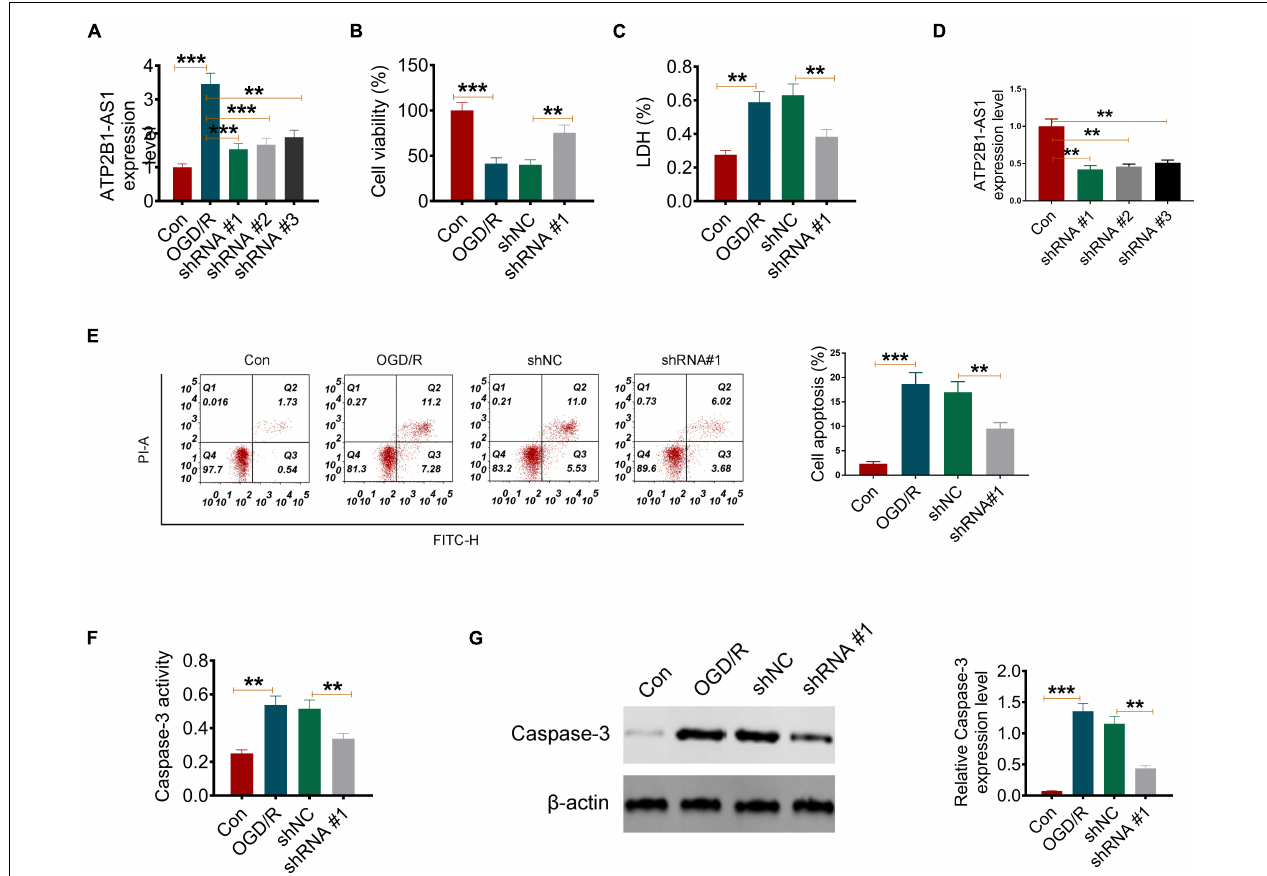
FIGURE 2 | Knockdown of ATP2B1-AS1 inhibits apoptosis and apoptosis-related factors of OGD/R PC12 cells. (A) The expression of ATP2B1-AS1 downregulated by shRNA ATP2B1-AS1 in the OGD/R-induced PC12 cells. (B) Knockdown of ATP2B1-AS1 increases the cell viability of OGD/R PC12 cells. (C) Knockdown of ATP2B1-AS1 reduces the LDH level of OGD/R PC12 cells. (D) The expression of ATP2B1-AS1 downregulated by shRNA ATP2B1-AS1 in PC12 cells without OGD/R treatment. (E) Knockdown of ATP2B1-AS1 inhibits the apoptosis rate of PC12 cells induced by OGD/R. (F) Knockdown of ATP2B1-AS1 decreases the Caspase 3 level of OGD/R PC12 cells. (G) Knockdown of ATP2B1-AS1 decreases the Caspase 3 activity of OGD/R PC12 cells. ** P < 0.01, *** P <